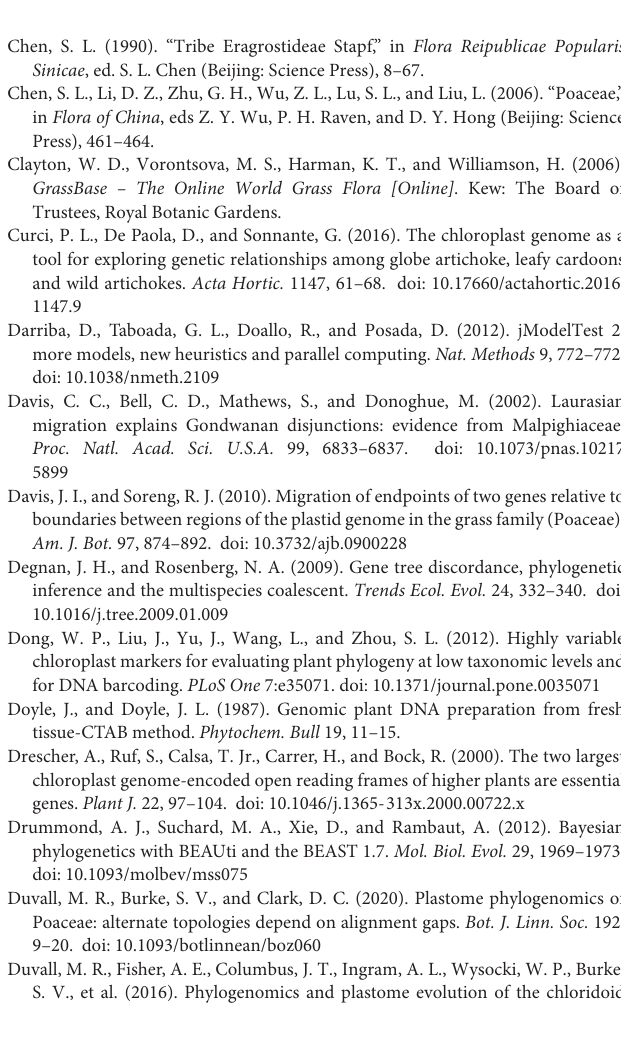
Supplementary Table 1 | List of genes annotated in 12 Cleistogenes plastomes. Supplementary Table 2 | Types of SSRs. Supplementary Table 3 | Results of codon usage analysis. Supplementary Table 4 | Percentage of each amino